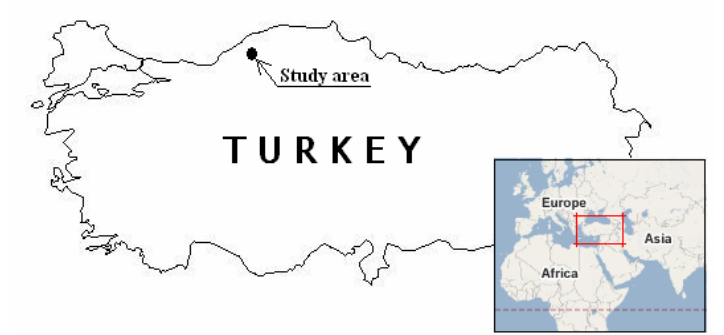
Figure 2 . Geographical location of the study